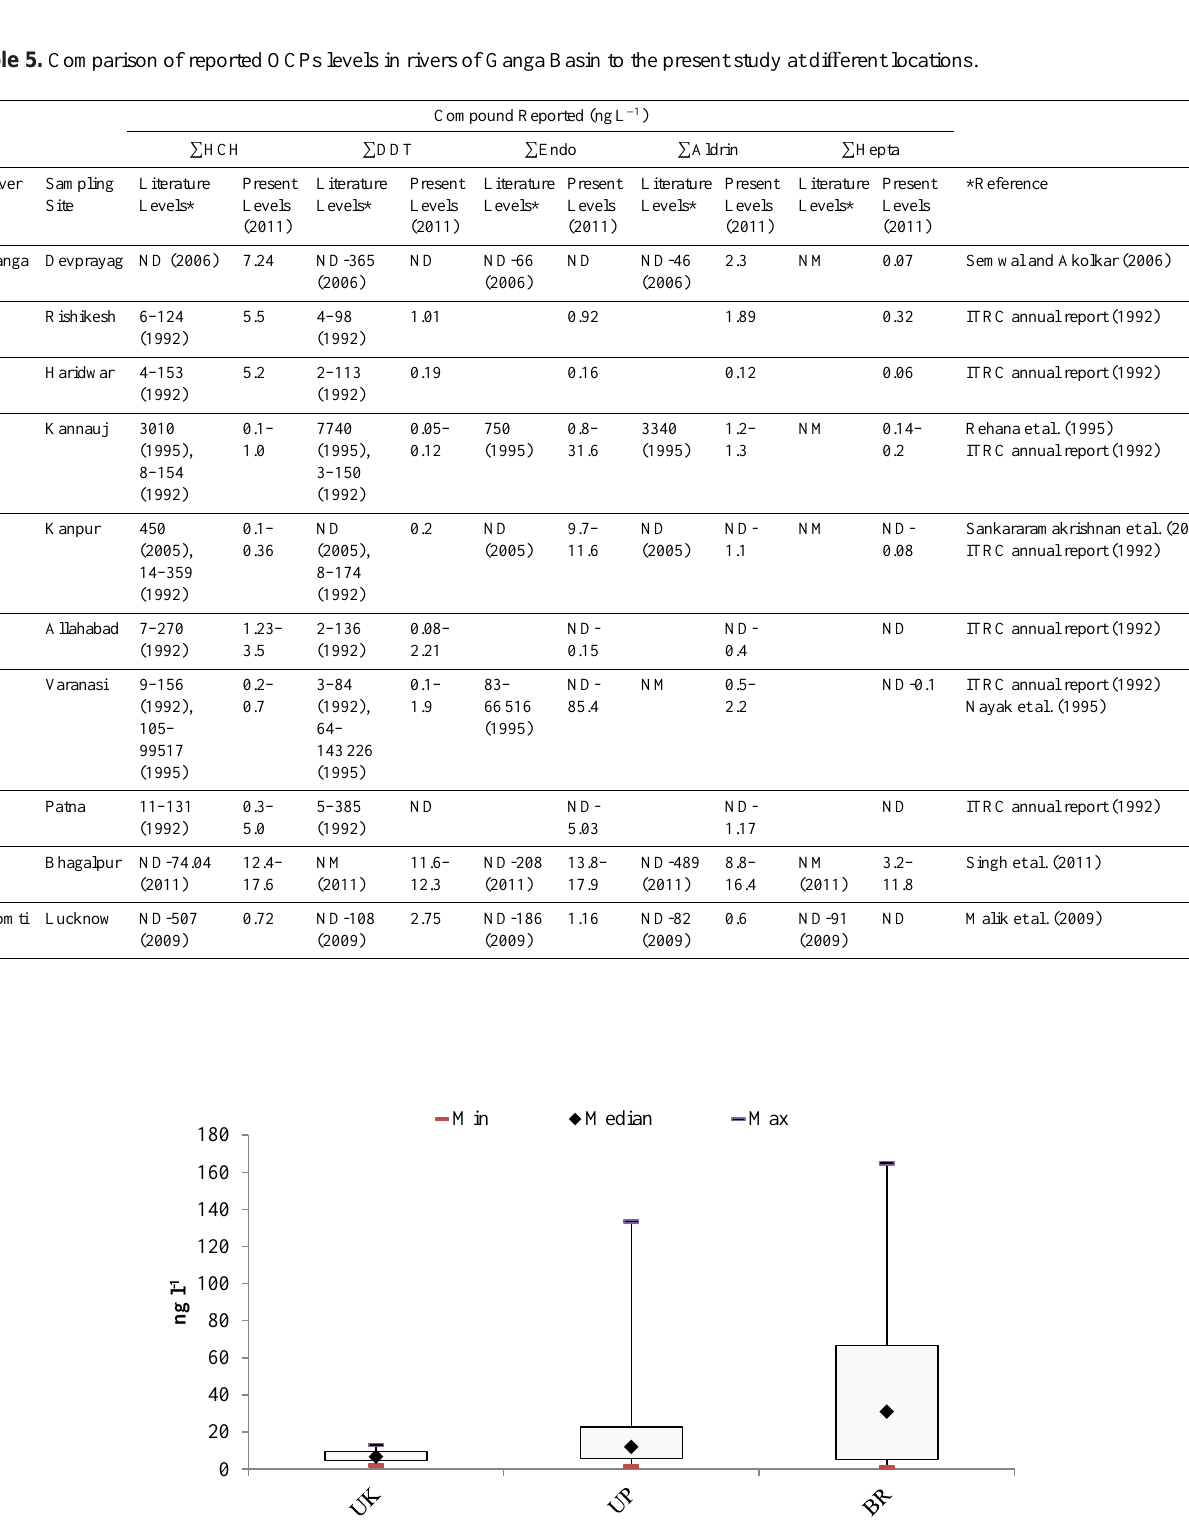
Figure 9. Variation in total OCPs residues in Ganges water (BIS Safe limit = 1000ngL − 1 Figure 9: Variation in total OCPs residues in Ganges water (BIS Safe limit = 1000 ng l -1 )